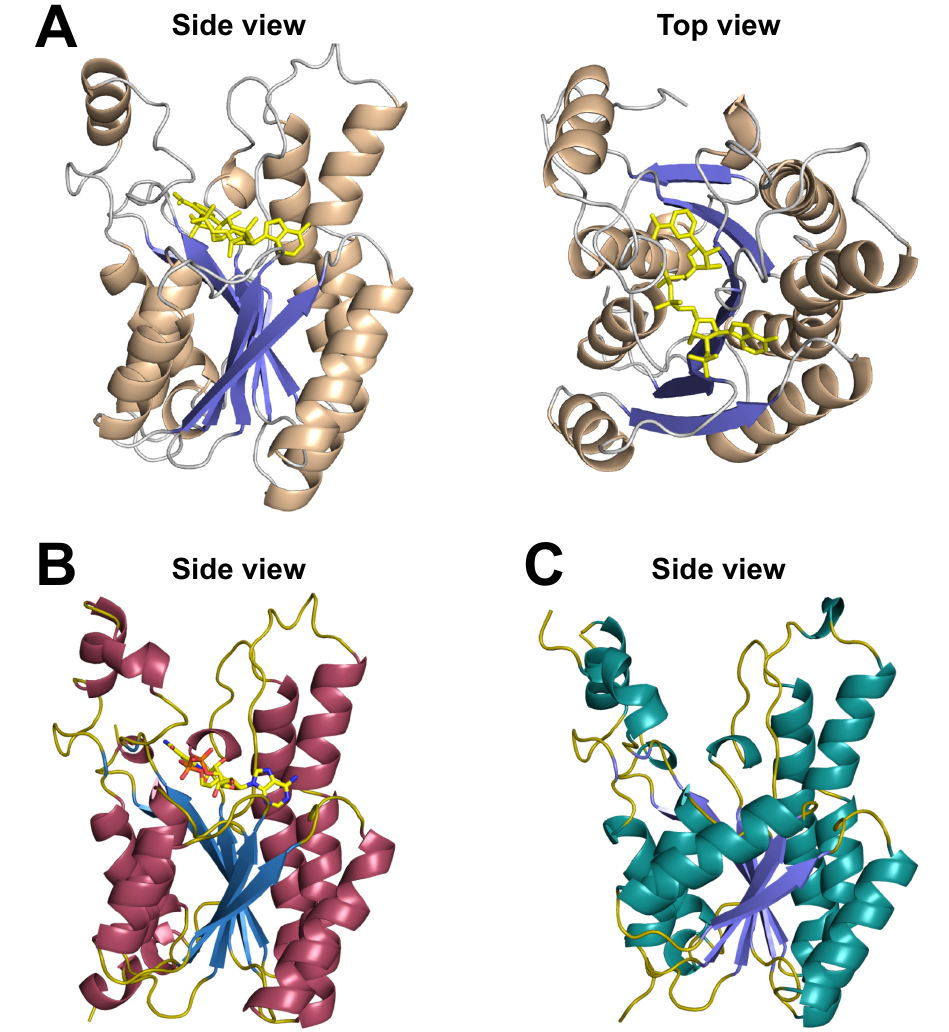
Figure 5. Crystal structure of SDR family enzymes. ( A ) NADP + -bound DEH reductase (A1-R) with a three-layered α / β / α structural fold [26]. α -helix, brown; β -strand, blue; loop and turn; gray; NADP + , yellow. ( B ) NAD + -bound KduD [43]. α -helix, purple; β -strand, blue; loop and turn; dark yellow; NADP + , yellow. ( C ) DhuD [28]. α -helix, cyan; β -strand, blue; loop and turn; dark yellow.